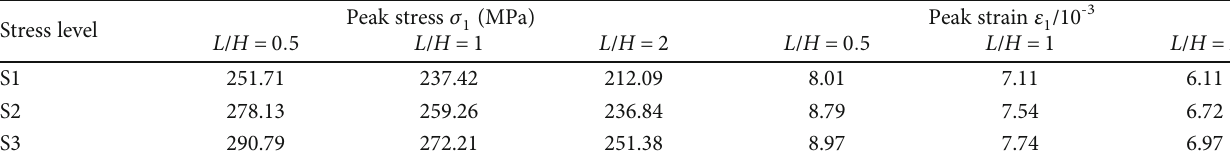
Table 4: Simulation results.